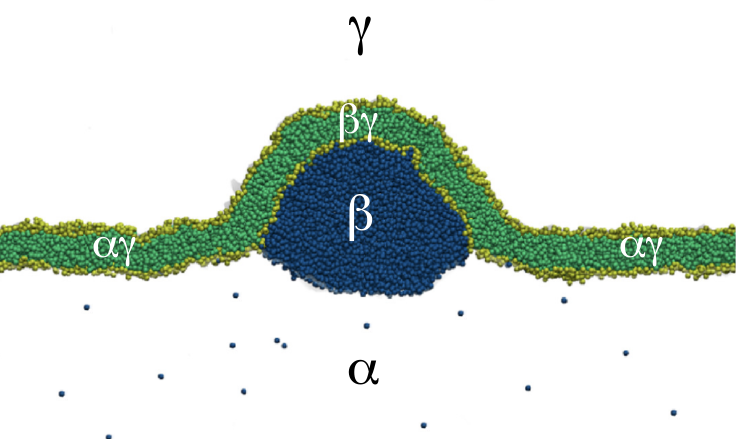
Figure 25. Partial engulfment of a condensate nanodroplet ( β , dark blue) by a planar bilayer, con- sisting of lipids with yellow headgroups and green lipid tails as studied by molecular dynamics simulations [29]. The αβ interface between the droplet and the liquid bulk phase α forms a contact line with the bilayer which partitions this bilayer into a βγ segment in contact with the β droplet and into an αγ segment exposed to the α phase as in Figure 1a.